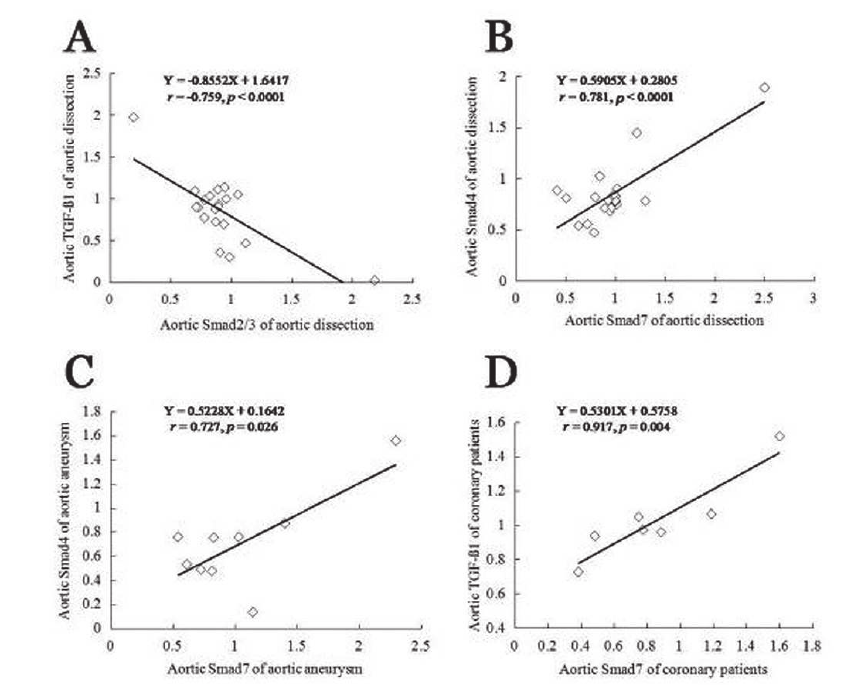
Fig. 4. Significant correlations of the relative positive net grayscales between (A) TGF-ß and Smad2/3 of the aortic dissection; (B) Smad4 and Smad7 of the aortic 1 dissection; (C) Smad4 and Smad7 of the aortic aneurysm; and (D) TGF-ß Smad7 of the coronary artery disease group